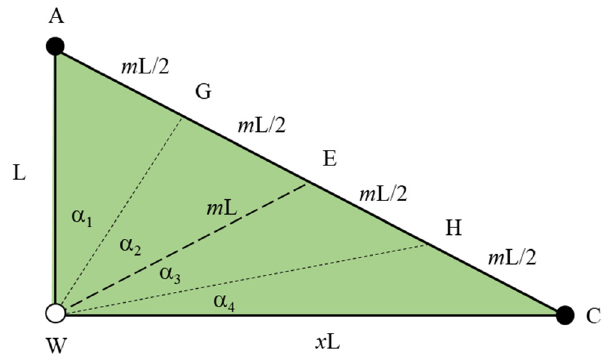
Figure 4. The injection–production unit of the rhombic inverted nine-point well pattern .